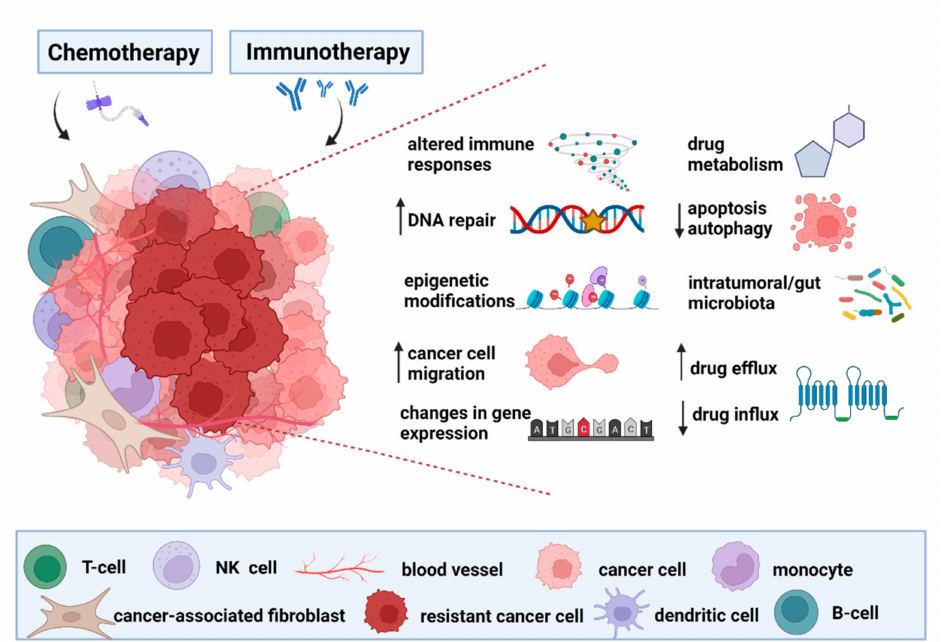
Figure 1. The proposed mechanisms of cancer treatment resistance. The altered expression of well- studied transmembrane proteins known as transporters contributes to a low influx or high efflux of chemotherapeutics, leading to a decreased level of intracellular drug delivery. Moreover, increased metabolism of chemotherapeutic agents can result in the breakdown of the molecules followed by reduced efficacy of anticancer therapy. Epigenetic modifications can have a role in the development of therapy resistance via two main mechanisms, including histone modification (methylation and acetylation) and DNA methylation, which correlate with tumorigenesis and subsequent therapy resistance. Reduced apoptosis and autophagy, as possible mechanisms of cancer defense against ther- apy, are markers of therapy resistance because of reduced cancer cell death. Epithelial–mesenchymal transition-related pathways contribute to treatment resistance and formation of metastatic cancer cells through decreased expression of cell adhesion molecules and improved cell motility.